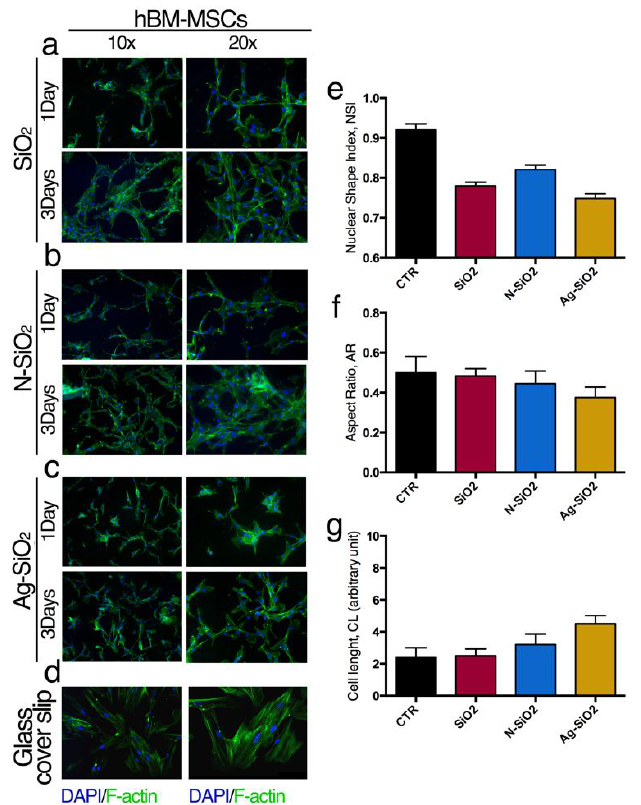
Figure 3. Interaction adult hBM-MSCs with nanoparticles: Immunofluorescence of hBM-MSCs seeded on ( a ) SiO 2 ; ( b ) N-SiO 2 ; ( c ) Ag-SiO 2 ; ( d ) Control culture. Fluorescein isothiocyanate)-Phalloidin (FITC): F-actin; 4',6-Diamidino-2-Phenylindole, Dihydrochloride (DAPI): nuclei. ( e ) Nuclear shape Index; ( f ) aspect ratio; ( g ) cell length. See method section for details.